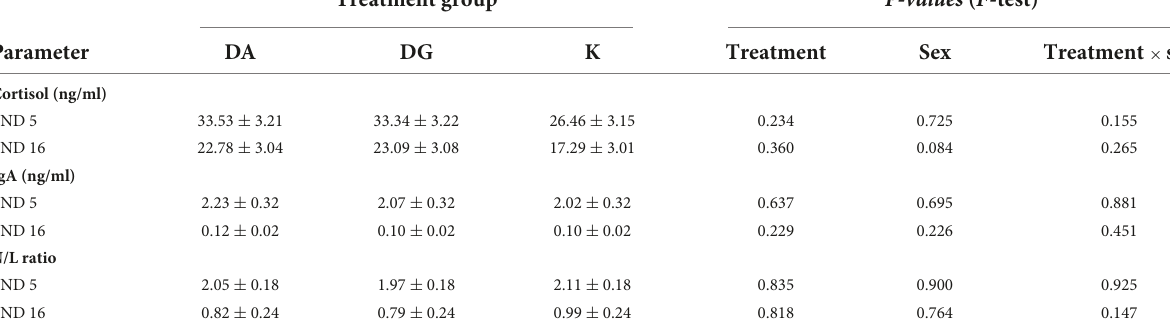
TABLE 3 Cortisol concentrations and immunological parameters in the blood of